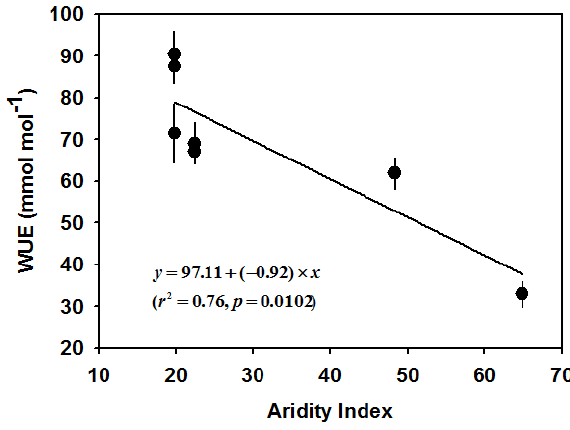
Figure 6. Water-use efficiency (WUE) of the Siberian elm leaf samples. The line indicates regressions of WUE versus annual precipitation ( r 2 = 0.76).